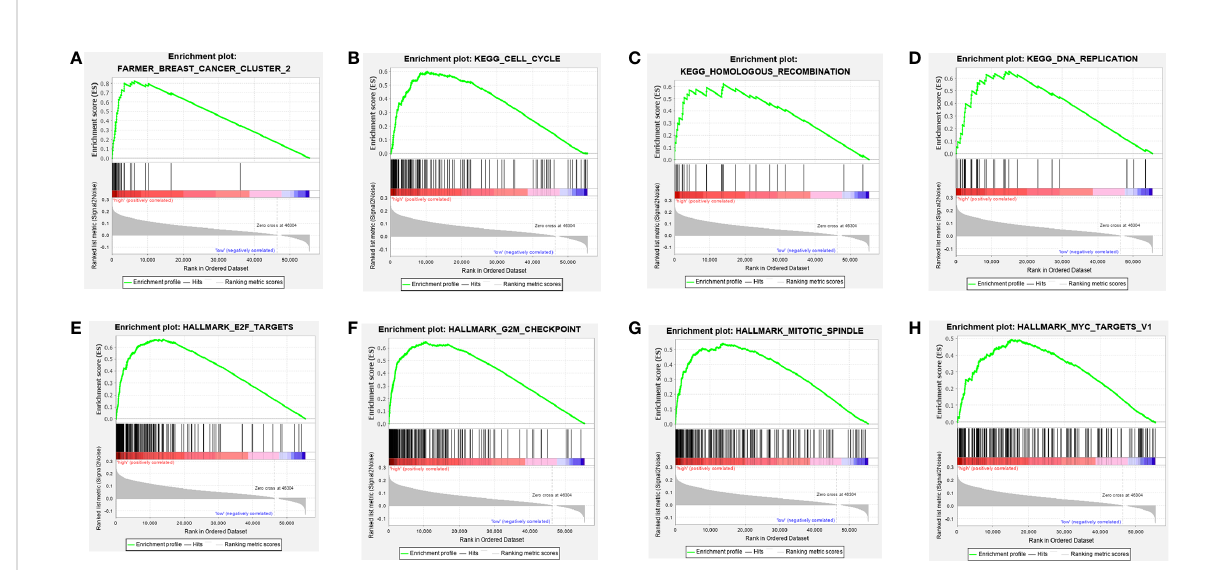
FIGURE 3 Enrichment plots from Gene Set Enrichment Analysis (GSEA). GSEA was used to indicate the mechanisms related to SNORA38 expression in breast cancer. GSEA disclosed a signi fi cant enrichment of (A) Breast cancer cluster 2. (B) Cell_cycle. (C) DNA_replication. (D)